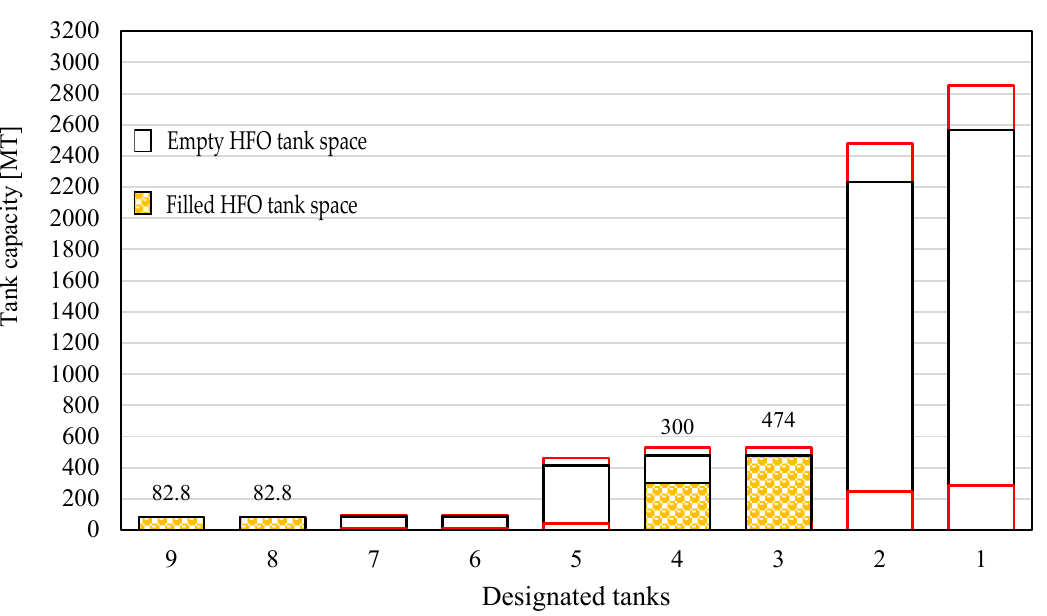
Figure 3. HFO bunker condition before bunker distribution for the first example.